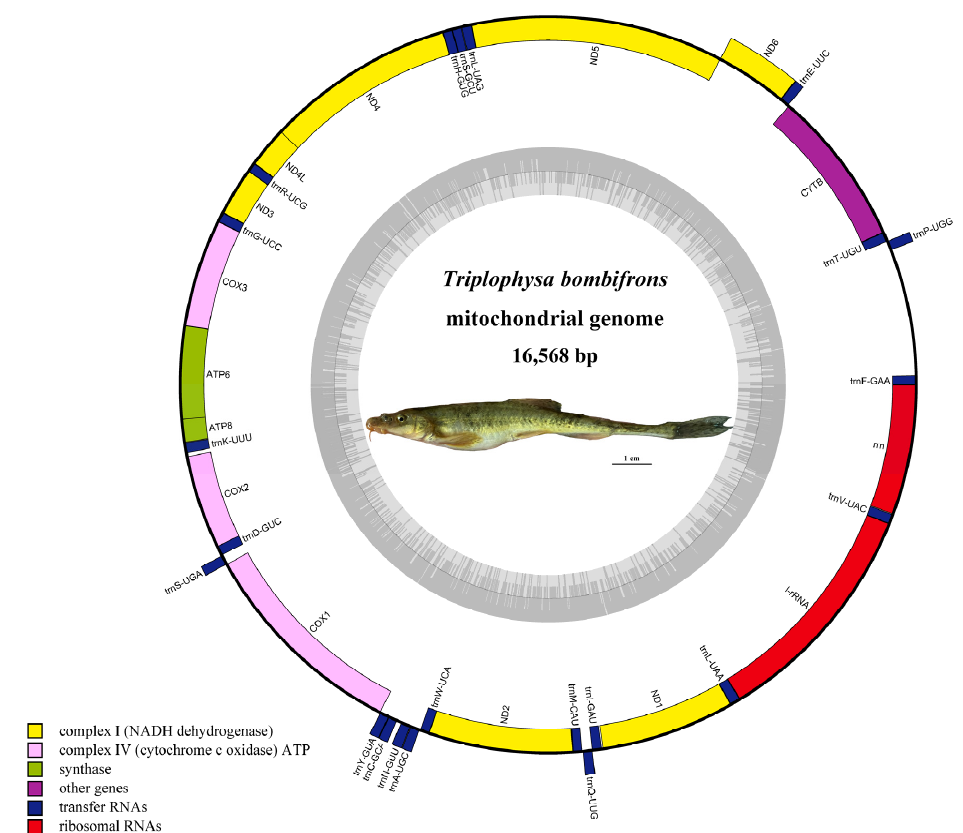
Figure 1. The circular map of the T. bombifrons mitogenome. The outer circle and inner circle represent the H-strand and L-strand, respectively. The GC and AT contents were plotted in the dark and light regions in the inner grey circle, respectively.